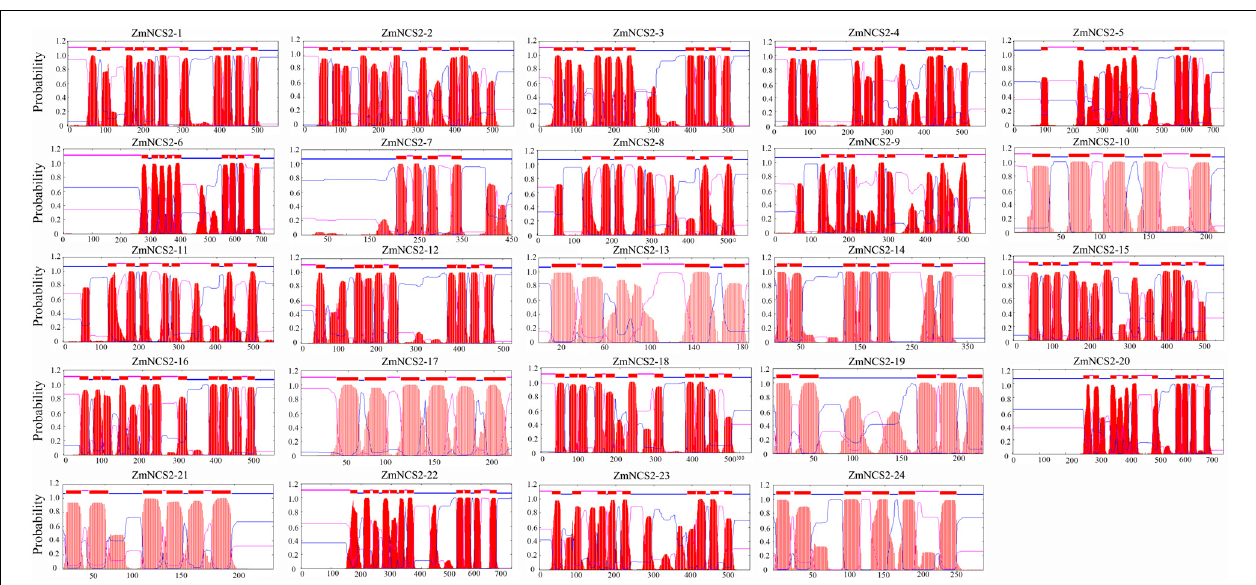
FIGURE 8 | Predicted transmembrane regions of ZmNCS2 proteins. Transmembrane regions were predicted using the TMHMM Server (version 2.0) (http://www.cbs.dtu.dk/services/TMHMM/).